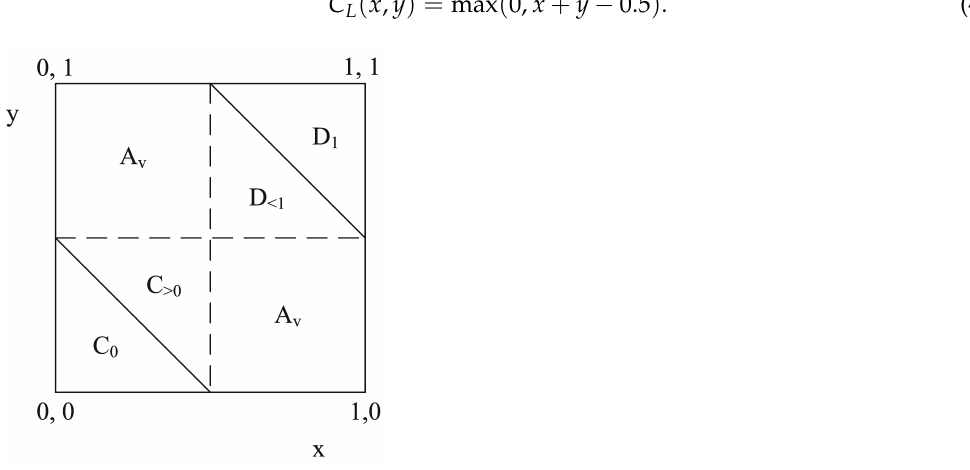
Figure 1. Classification into three classes, no , maybe , yes , by ordinal sums of conjunctive and disjunc- tive